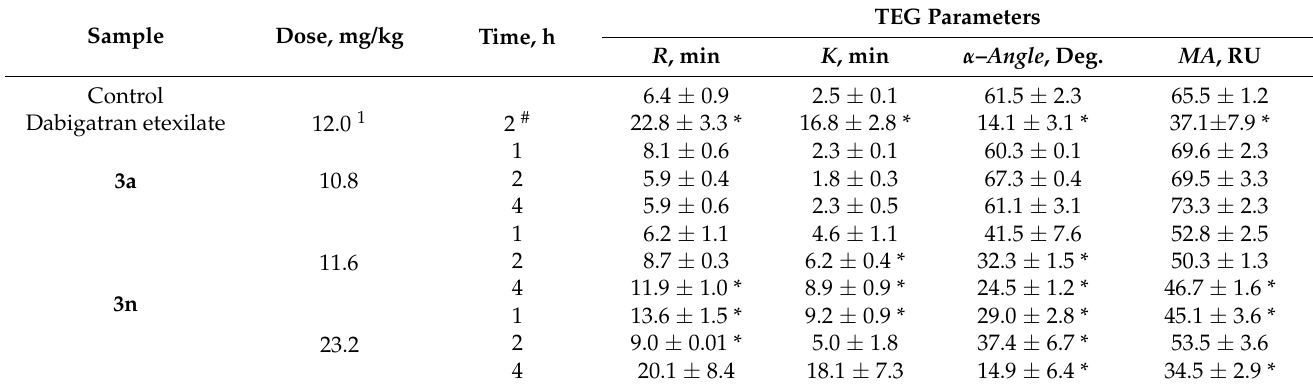
Table 9. Effect of compounds 3a and 3n on the TEG of rats after a single intragastric administration at various intervals in an increased doses (M ± m, n =